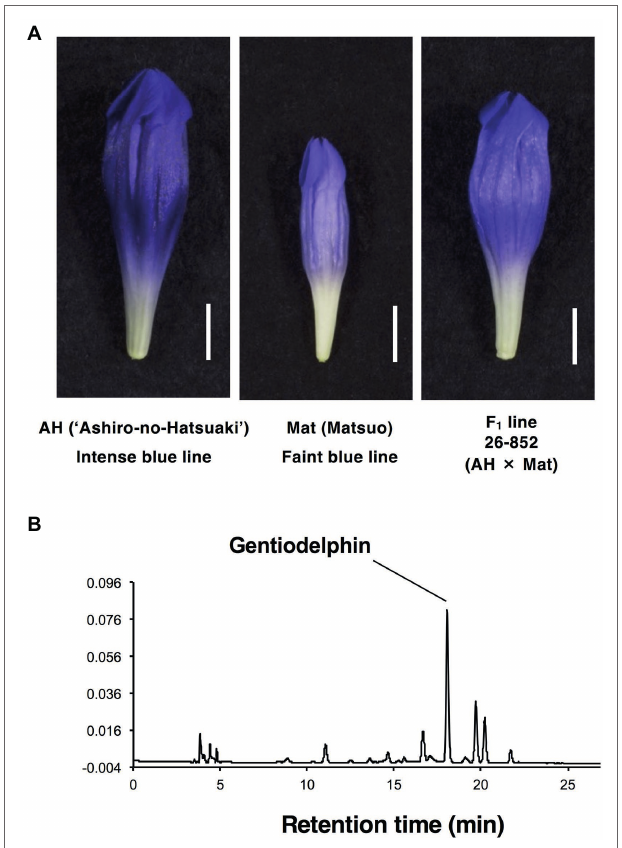
FIGURE 1 | Flower phenotypes of parents and F 1 used for crossing in this study. (A) AH, intense-blue doubled haploid line 26-853_Go1230 in gentian cultivar ‘Ashiro-no-Hatsuaoi’. Mat, faint-blue flower line 24-2007MAR7-Go5 doubled haploid. F 1 line 26-852 (AH x Mat). (B) Chromatogram of anthocyanin pigment extracts from petals of the AH line at 520